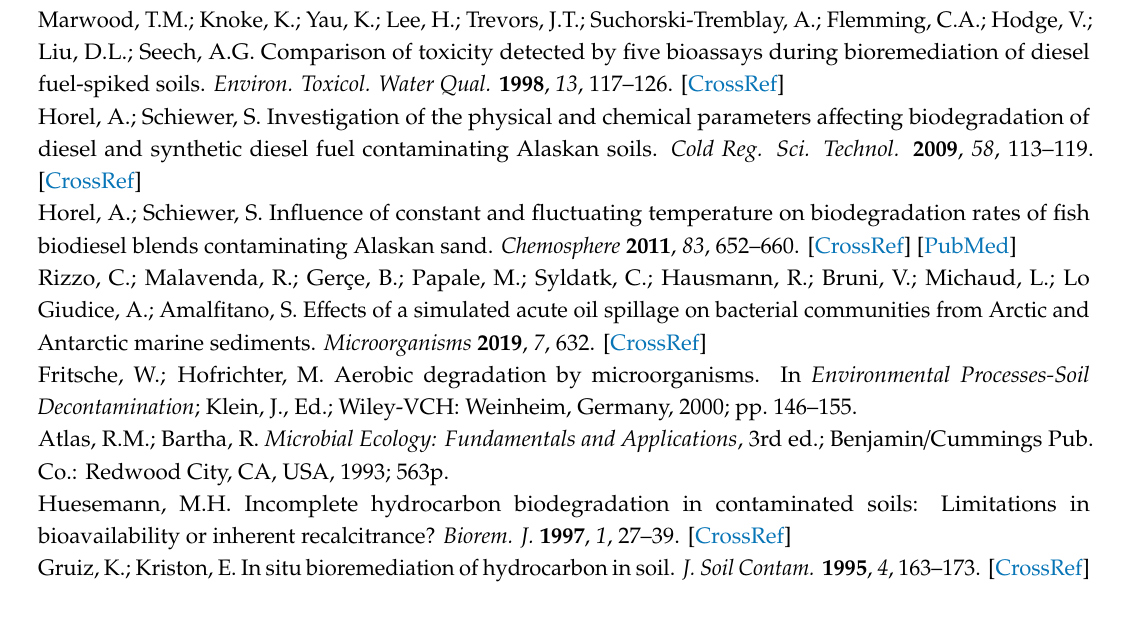
Figure S1. Microscopic pictures of a) fungal mycelium and b) Trichoderma sp. collected from fish biodiesel contaminated soil samples. Figure S2. Fungal growth on fish biodiesel contaminated soil